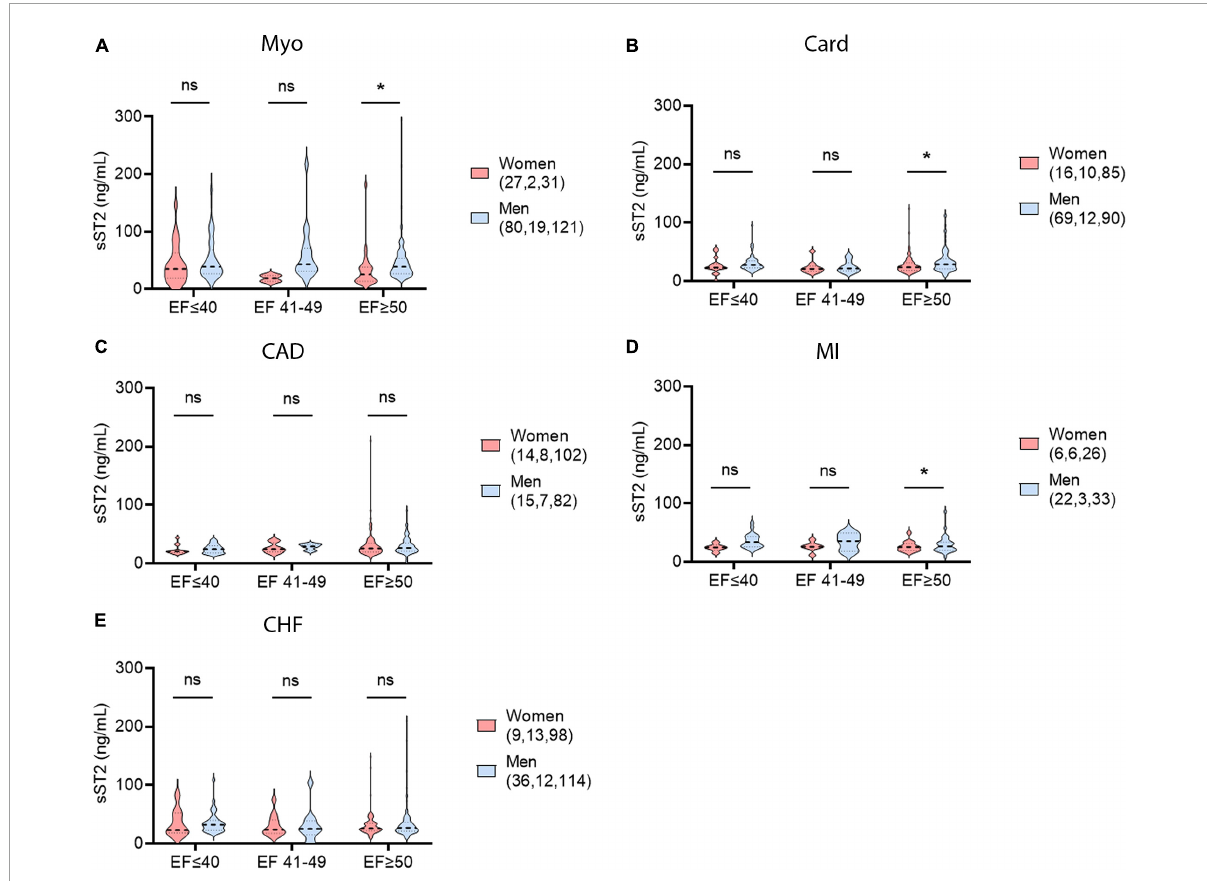
FIGURE7 Sex differences in LVEF and sST2 using ESC guidelines. sST2 levels compared women (peach) vs. men (blue) in patients with HFrEF, HFmrEF, or HFpEF for (A) myocarditis (Myo), (B) cardiomyopathy (Card), (C) coronary artery disease (CAD), (D) myocardial infarction (MI), or (E) congestive heart failure (CHF). Violin plots denote data distribution for each group. One-way ANOVA: (A) p = 0.053, (B) p = 0.032, (C) p = 0.72, (D) p = 0.093, and (E) p = 0.89 with two-way comparisons analyzed using unpaired Student’s t- test: ∗ , p < 0.05; ns, not significant. (A) Two-way ANOVA p -values indicate no interaction between sex and ejection fraction (EF) in patients with myocarditis ( p = 0.51), or EF and sST2 ( p = 0.29), but interaction between and sex and sST2 ( p = 0.025). (B) Two-way ANOVA p -values indicate no interactions between sex and EF ( p = 0.69), EF and sST2 ( p = 0.16), or sex and sST2 ( p = 0.15) in patients with cardiomopathy. (C) Two-way ANOVA p -values indicate no interactions between sex and EF ( p = 0.89), EF and sST2 ( p = 0.20) or sex and sST2 ( p = 0.81) in patients with CAD. (D) Two-way ANOVA p -values indicate no interactions between sex and EF ( p = 0.42) and EF and sST2 ( p = 0.77), but interaction between sex and sST2 ( p = 0.032) in patients with MI. (E) Two-way ANOVA p -values indicate no interactions between sex and EF ( p = 0.95), EF and sST2 ( p = 0.68), or sex and sST2 ( p = 0.84) in patients with